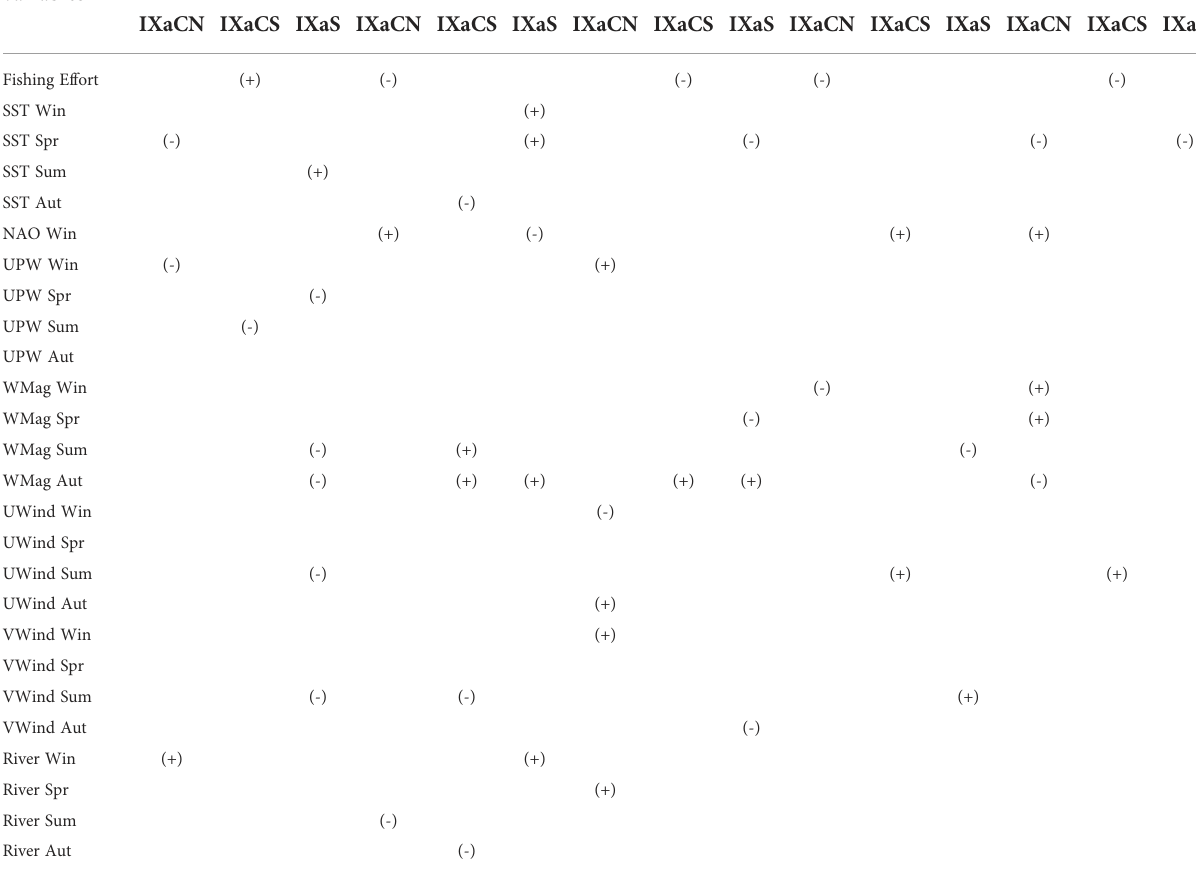
TABLE 4 Summary of results of relationships (signi fi cant in two or more time series analysis) between each fl at fi sh species (Landings per unit effort- LPUE) and explanatory variables ( fi shing effort and environmental factors) using Min/Max Autocorrelation Factor Analysis (MAFA), Dynamic Factor Analysis (DFA) and Generalised Least Squares (GLS) corresponding to the age-group I (Lag2 for Pleuronectes platessa , Microchirus spp., Solea lascaris and Solea solea , and Lag1 for Dicologlossa cuneata ), along the Portuguese coast: Northwest (IXaCN), Southwest (IXaCS) and South